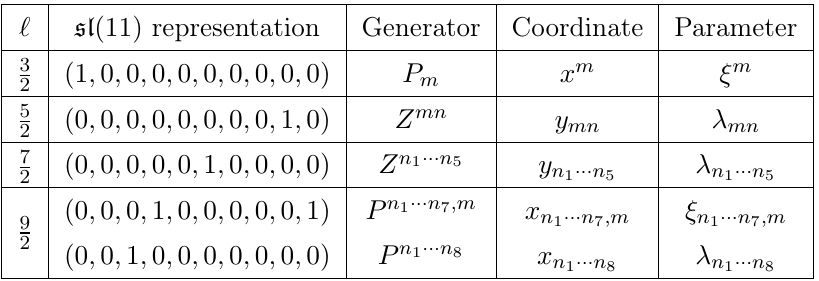
Table 5 . Level decomposition of the representation R ((cid:3) 1 ) of e 11 under gl (11) , up to level ‘ = 11 = 2 .